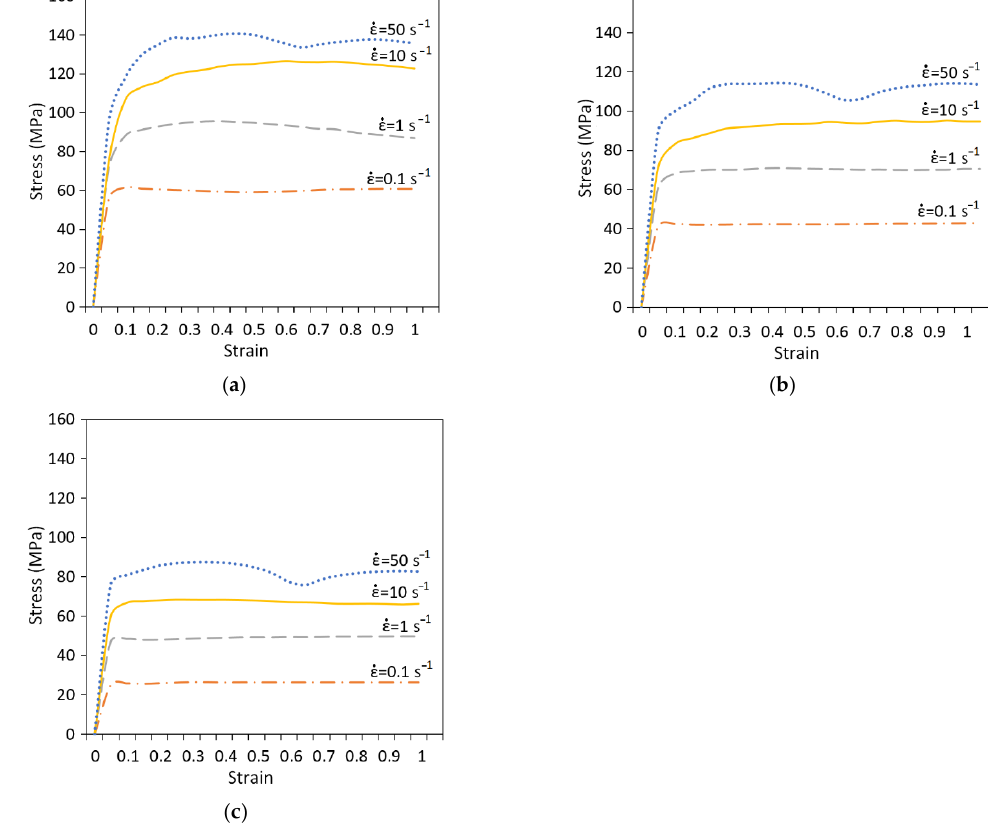
Figure 1. Resistance to deformation of Al-Zn-Mg-Ni-Fe alloy at deformation temperature: ( a ) 400 °С; ( b ) 450 °С; ( с ) 500 °С. The designed 3D model consists of three rolls and a workpiece (Figure 2). The initial workpiece axis coincides with the rolling axis; each roll is turned through the feed angle β = 20° and toe angle γ = 7°. The distance from the pitch point of each roll to the rolling axis is set equal to the bar ’s radius. ( b ) Figure 2. 3D model for simulation ( a ) and scheme of roll angles for the RSR process ( b ). The main parameters given in the pre-processor program are presented in Table 1. Table 1. Parameters of model for simulation of RSR process. Parameter Value Workpiece: - diameter, mm - length, mm - workpiece temperature, °С 30 150 400, 500